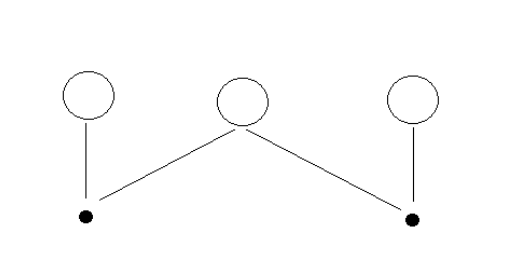
Figure 2: The leaf class space M 2,1 / ̃︂ F 2,1